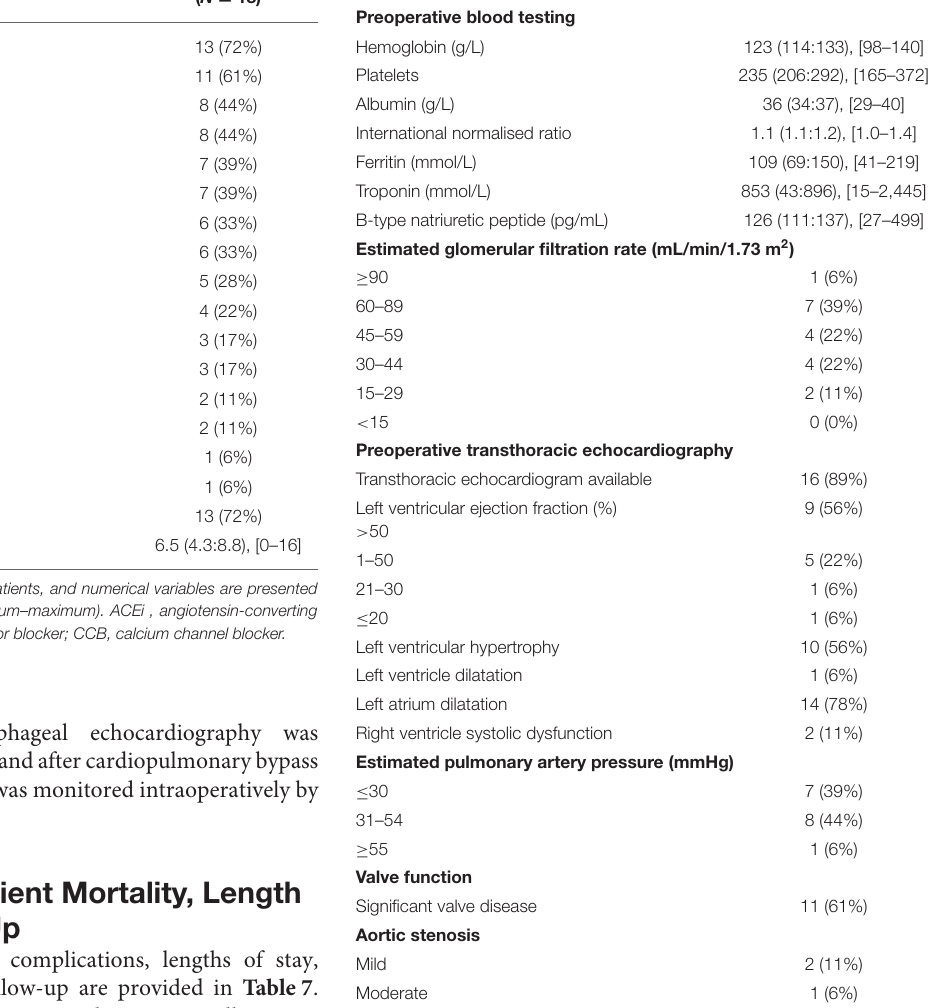
TABLE 3 | Preoperative variables of nonagenarians undergoing open cardiac surgery. ( N = 18)